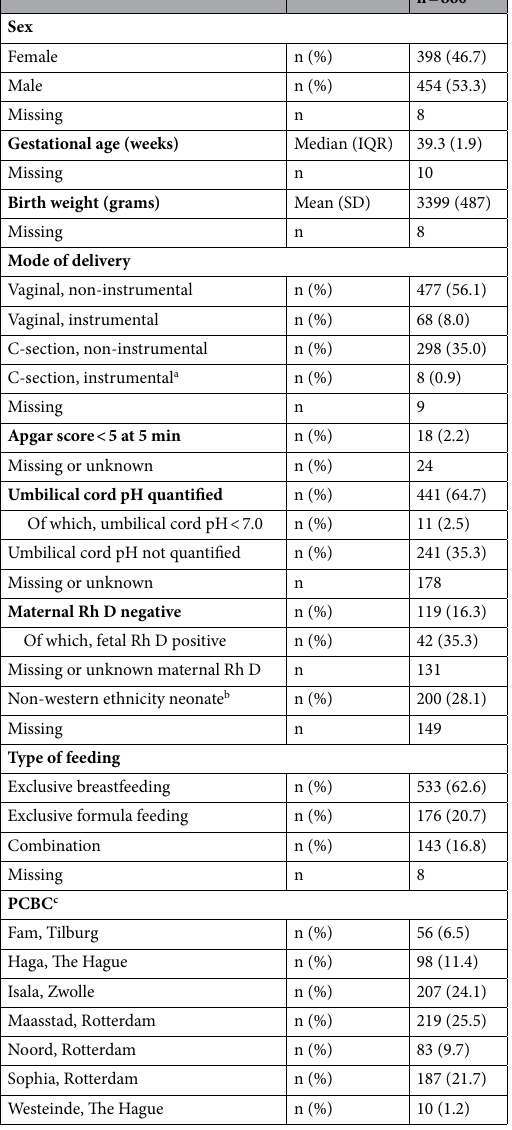
Table 1. Baseline characteristics. SD standard deviation, IQR interquartile range, PCBC primary care birth centre. a C-section, instrumental refers to (1) a vaginally, instrumental delivery that failed and subsequently